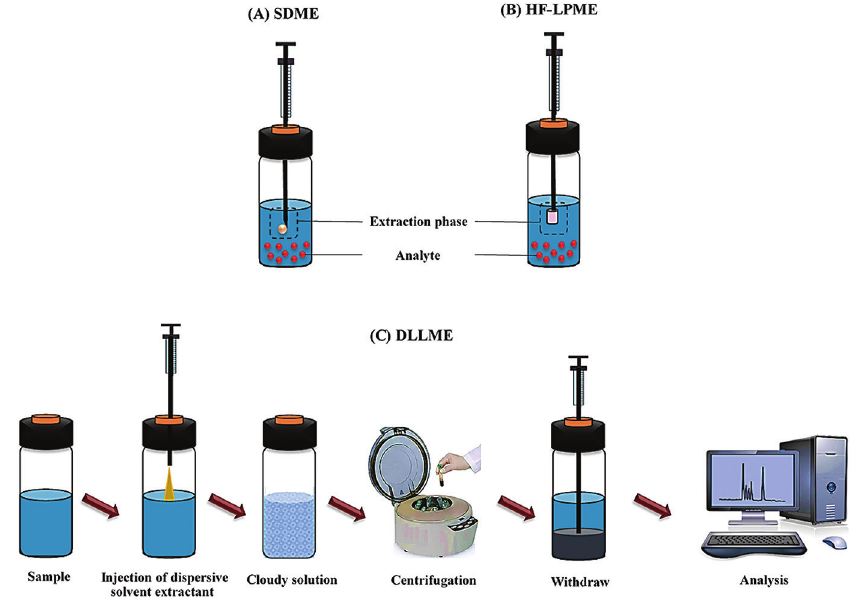
Figure 4: Schematic of different types of LPME techniques: (A) SDME, (B) HF-LPME, and (C)